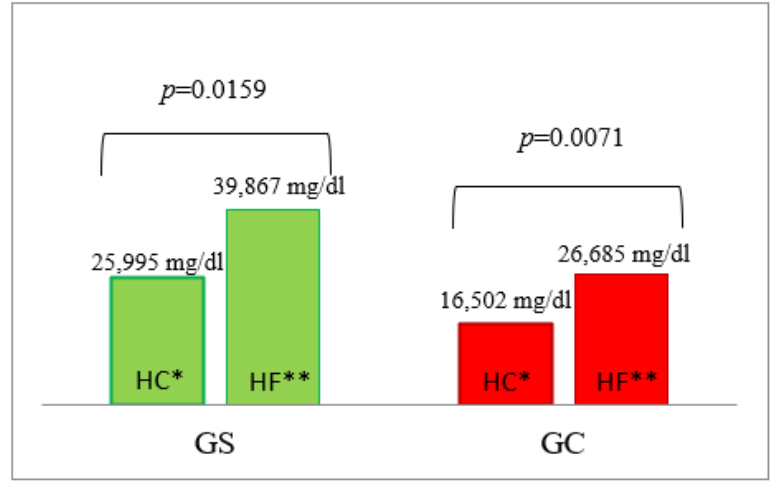
Figure 3. The AUC of triglyceride concentrations in the G S and G C groups after HC and HF meals. The results are presented as the mean values. * difference between the G S (obese/overweight) and G C (normal body weight) groups after HC meal (high-carbohydrate meal ( p = 0.0274)); ** difference between the G S and G C groups after HF meal (high-fat meal ( p = 0.0240)).